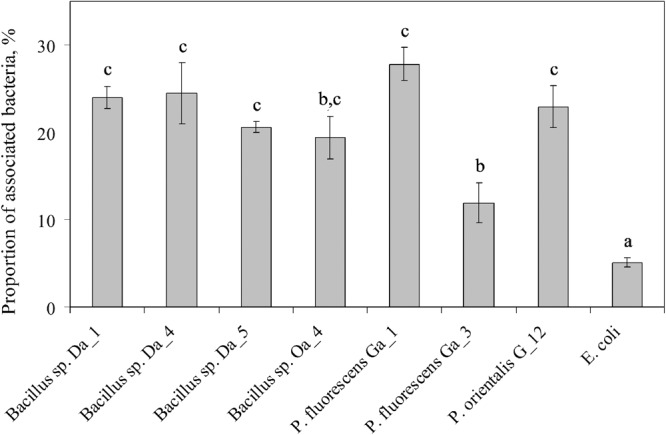
Association of endophytic bacteria with apple cells in suspension. Apple cell suspension was inoculated with each strain at a final concentration of ∼107 cfu/ml. After 6 h of co-incubation, the apple cells were sedimented by centrifugation and associated bacterial cells were quantified by serial dilution. Data are presented as the mean and SEM of at least three repeats from three independent experiments. Means followed by the same letter are not significantly different (p < 0.05).